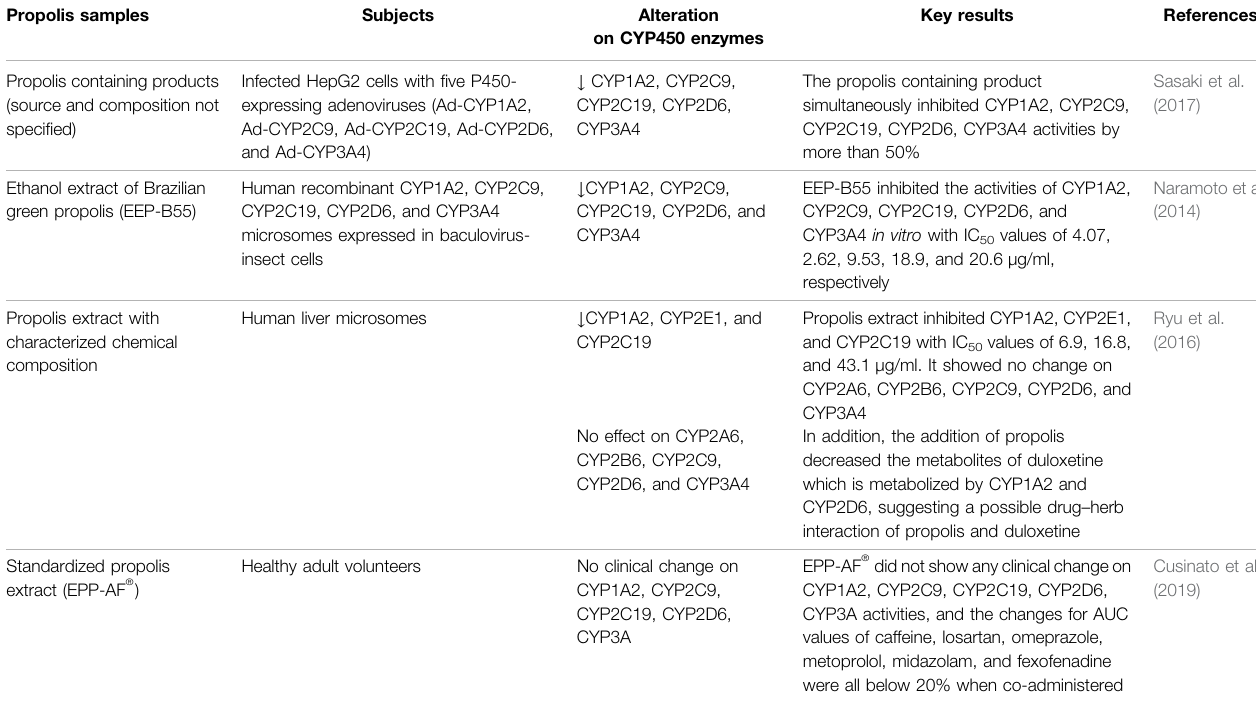
TABLE 3 | The effect of propolis on CYP450 in vitro , in vivo, and